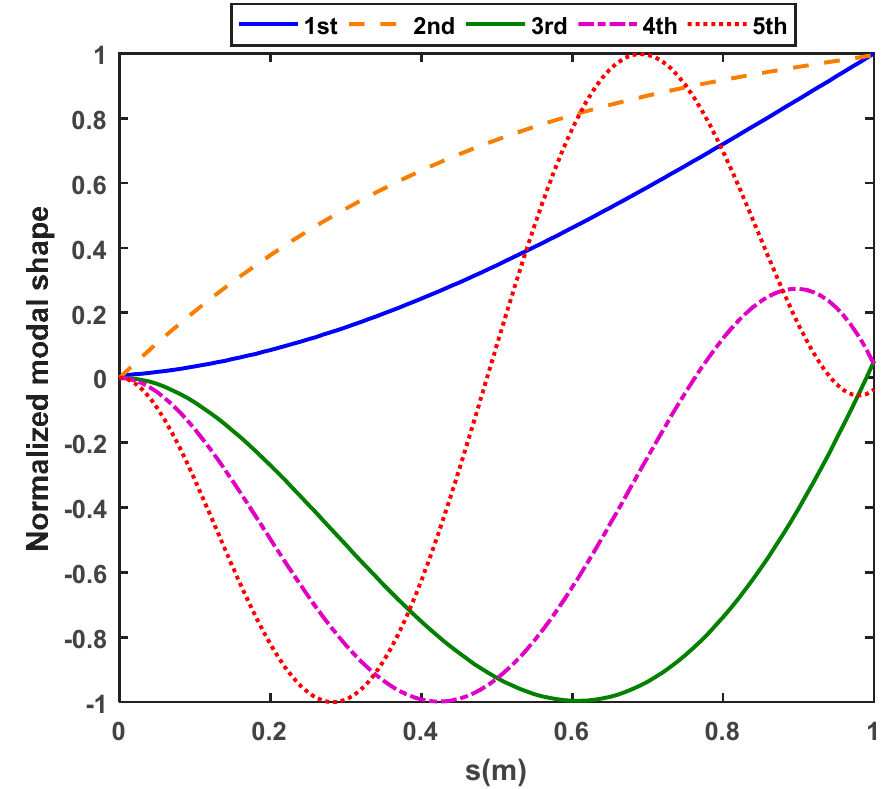
Figure 8. Modal shapes of the SFF system.